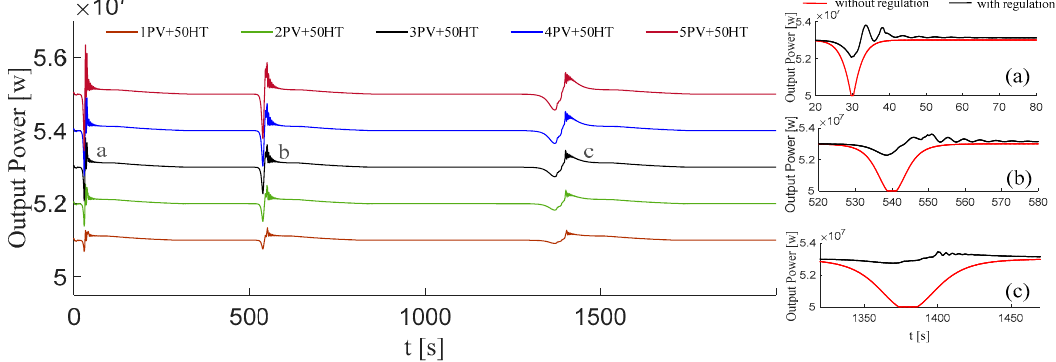
Figure 14. Output power of a PV-HT hybrid system with 100% solar radiation fluctuation, for fluctuation times of 1, 2, and 10 min; ( a – c ) are the comparisons of output power with and without hydro turbine regulation of a 3 MW photovoltaic system.